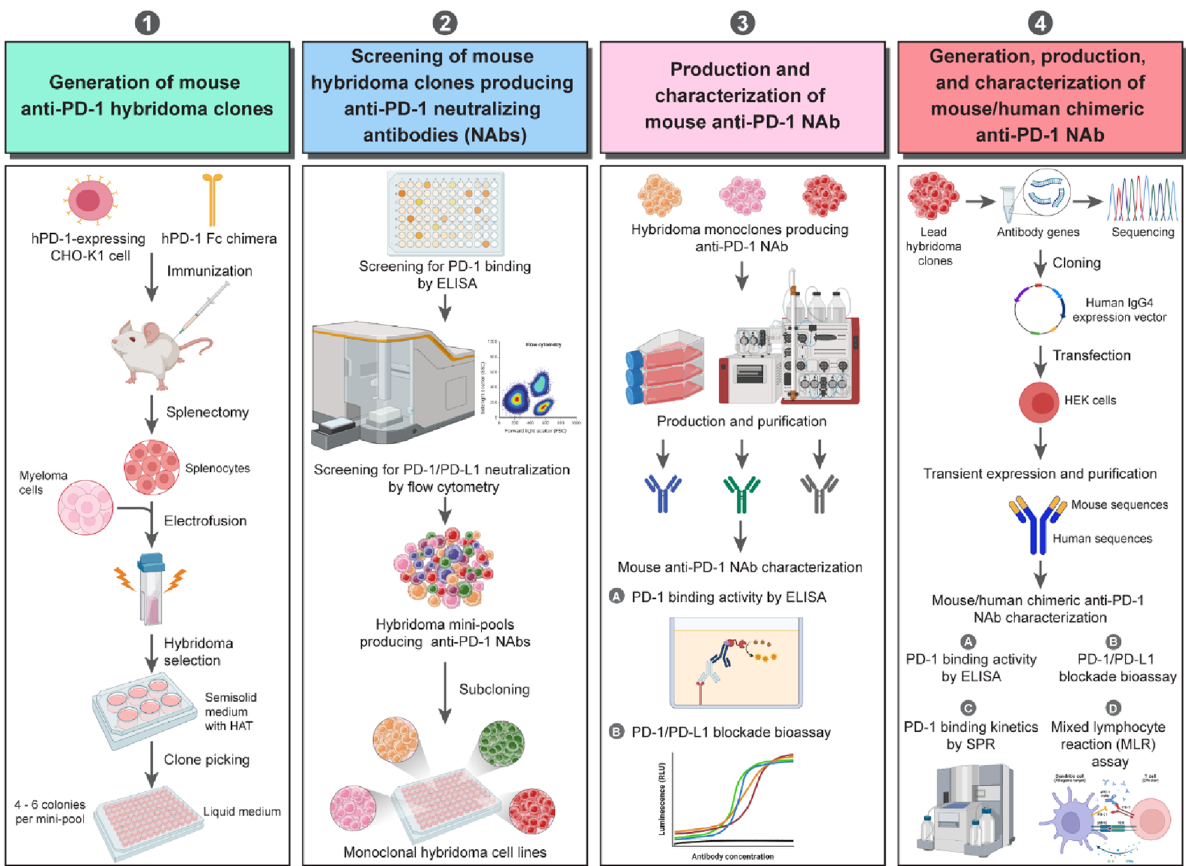
Figure 1. Workflow of the generation, screening, and characterization of the chimeric anti-PD-1 monoclonal antibodies. Four sequential steps of this workflow are